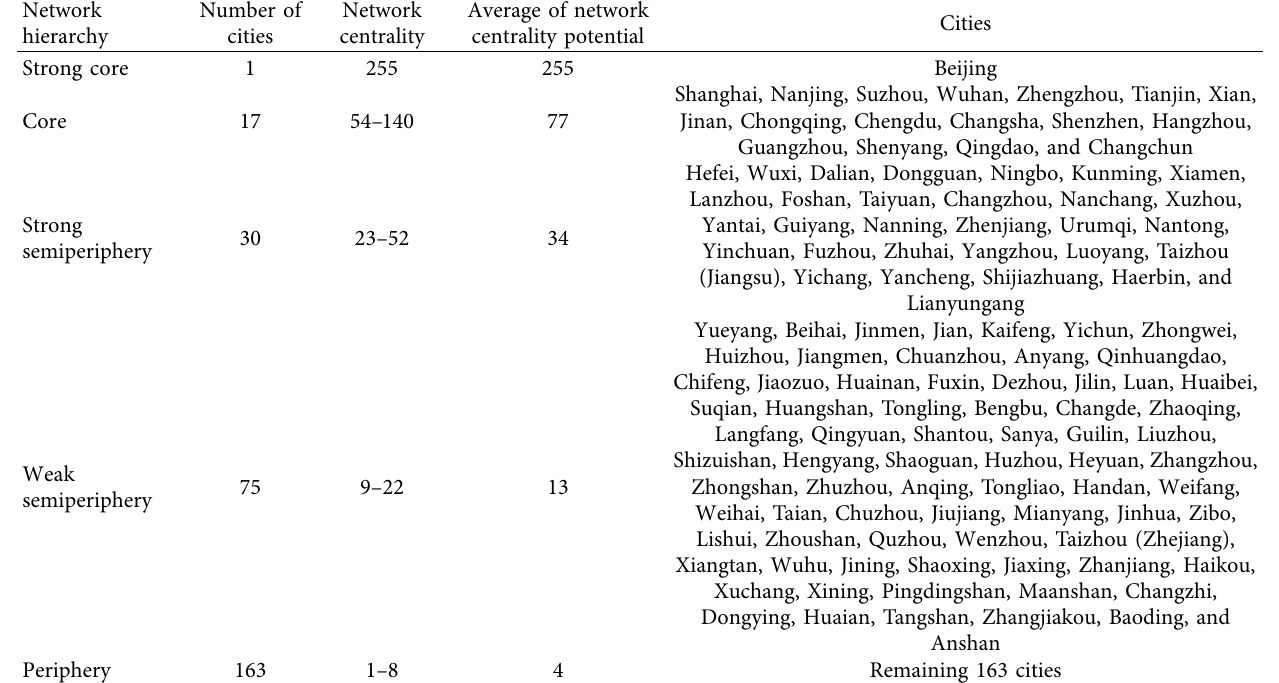
Table 2: Hierarchy of China’s intercity innovation